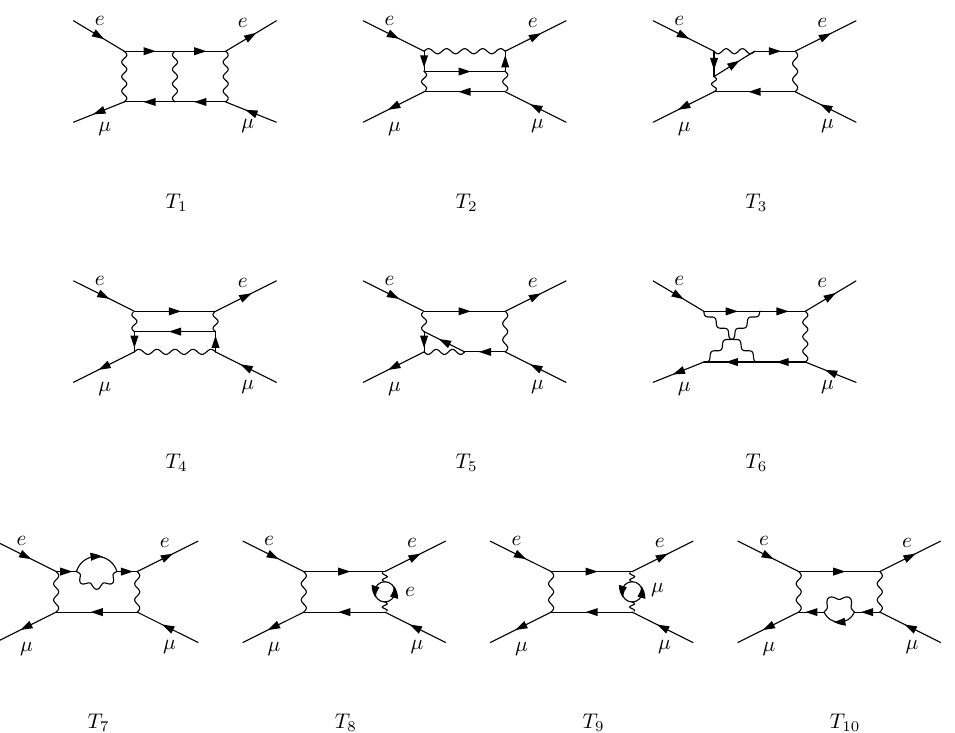
Figure 1. Two-loop four-point topologies for (cid:22)e